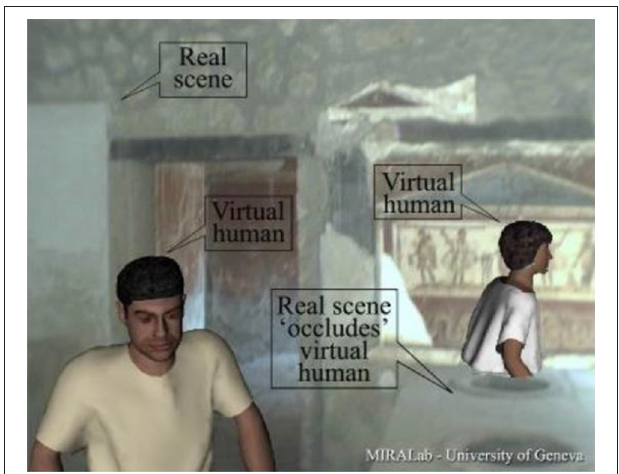
FIGURE 5 | LIFEPLUS project [19], reproduced with the permission of the copyright holder (LIFEPLUS project).